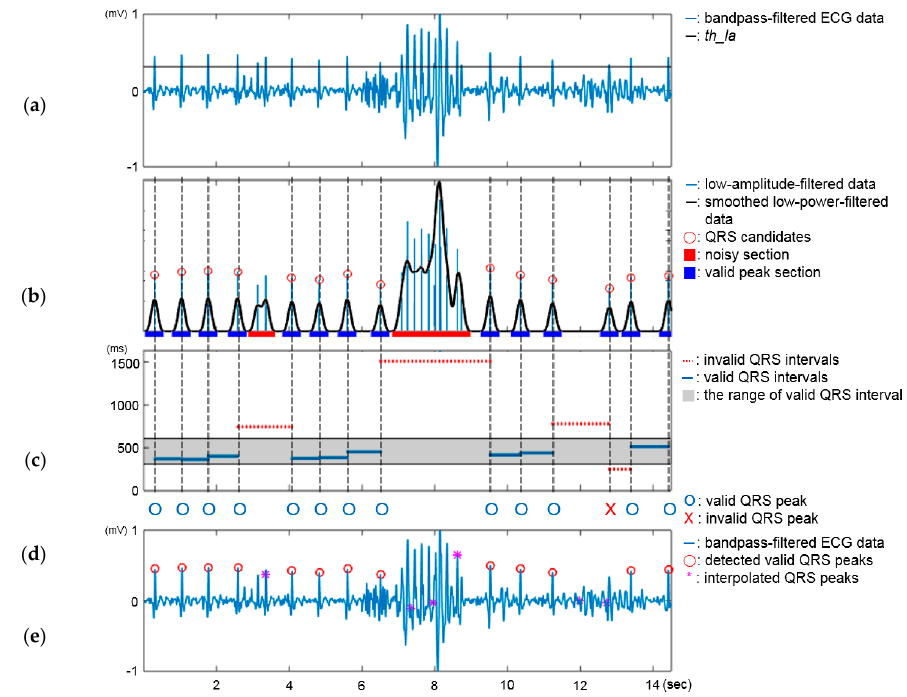
Figure 3. The detection and correction process of the QRS peak detector. ( a ) Blue solid line: bandpass-filtered ECG data; black solid line: the threshold for low-amplitude filtering, th_la ; ( b ) blue line: low-amplitude-filtered data; black solid line: smoothed signal of the blue line; red circle: detected QRS candidates; red bar: noisy section; blue bar: valid QRS peak section; ( c ) gray box: the range of valid intervals; blue solid lines: valid intervals; red dotted lines: invalid intervals; ( d ) O: valid QRS peak; X: invalid QRS peak; ( e ) blue solid line: bandpass-filtered ECG; red circle: detected QRS peaks after correction; magenta star: interpolated QRS peaks. Table 1. The correction rule for the wrongly-detected QRS peaks by invalid short